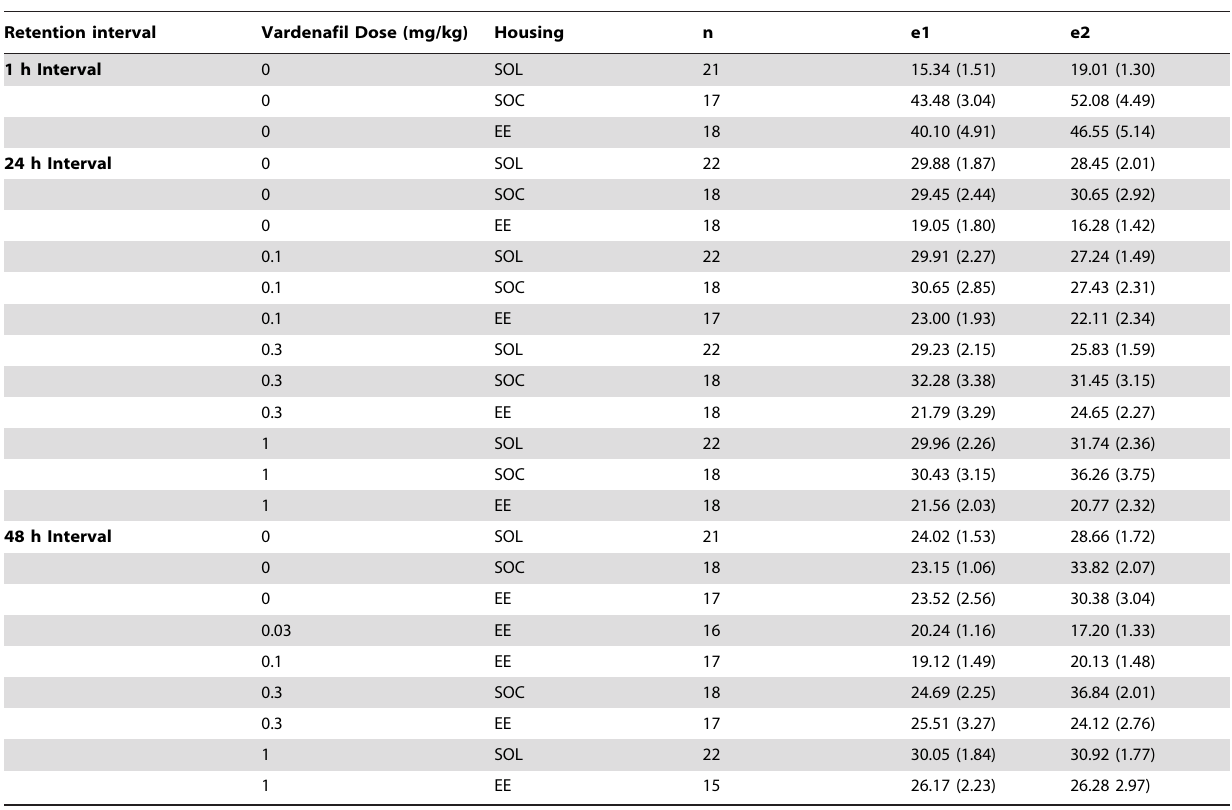
Table 1. Exploration levels in the ORT.